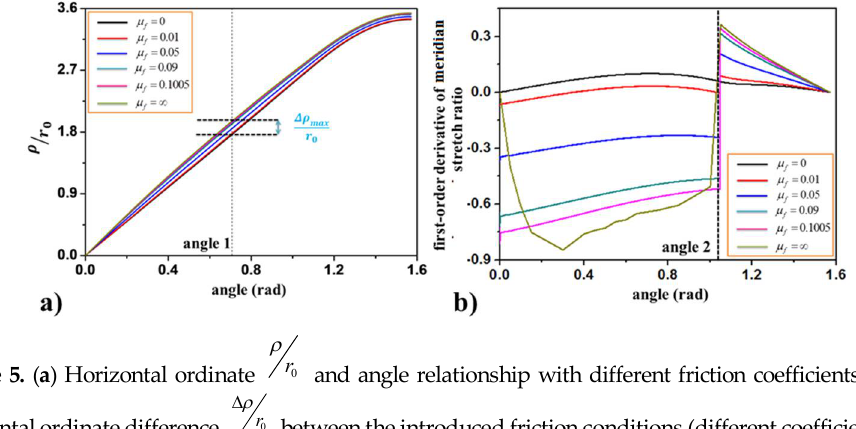
Figure 5. ( a ) Horizontal ordinate 0 horizontal ordinate difference 0 r the frictionless